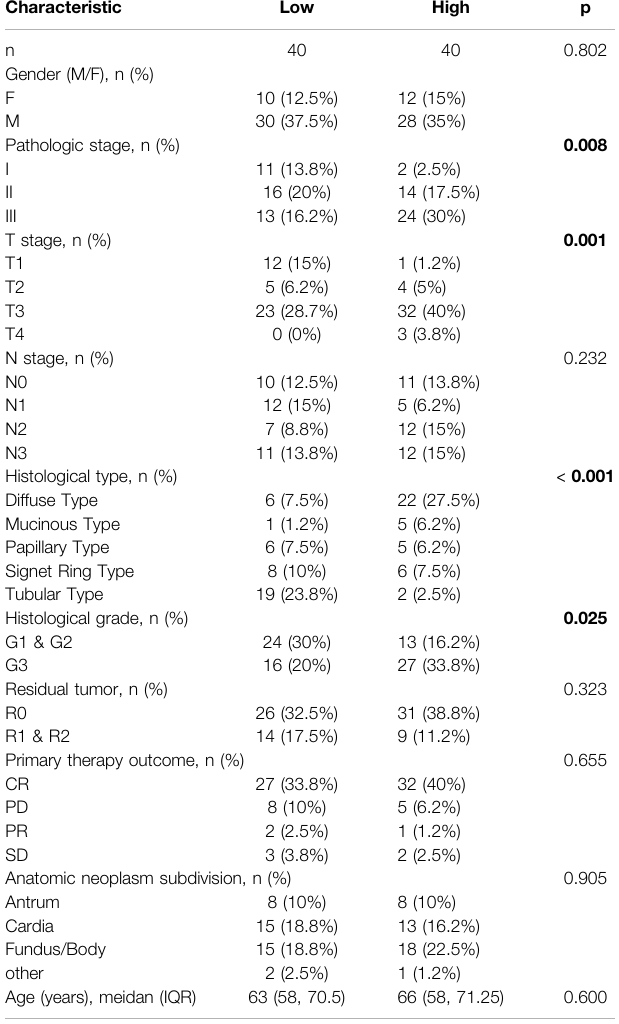
TABLE 6 | The relationship between BGN expression and clinicopathological variables in 80 patients underwent immunohistochemistry.